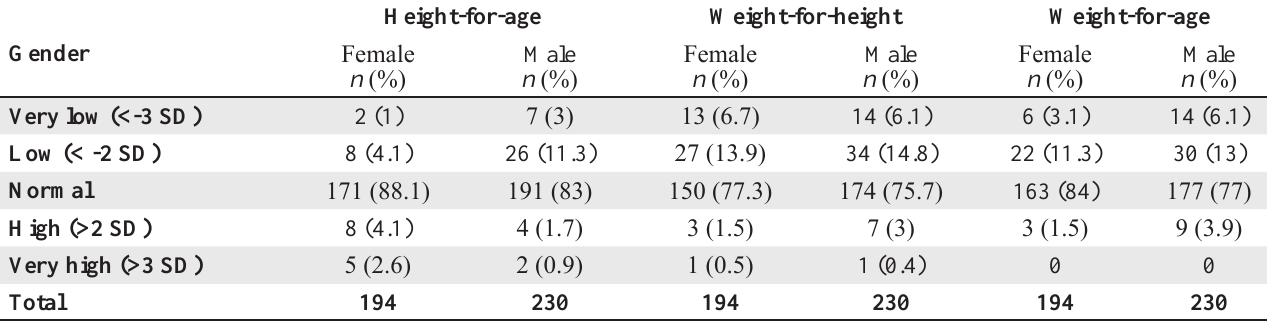
Table 1 : Anthropometric values for both gender. (N = 424)